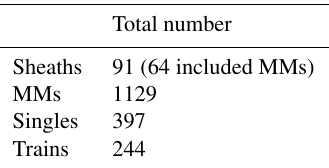
Table 1. Statistics of mirror mode (MM) occurrence and the number of single MMs and MM trains.